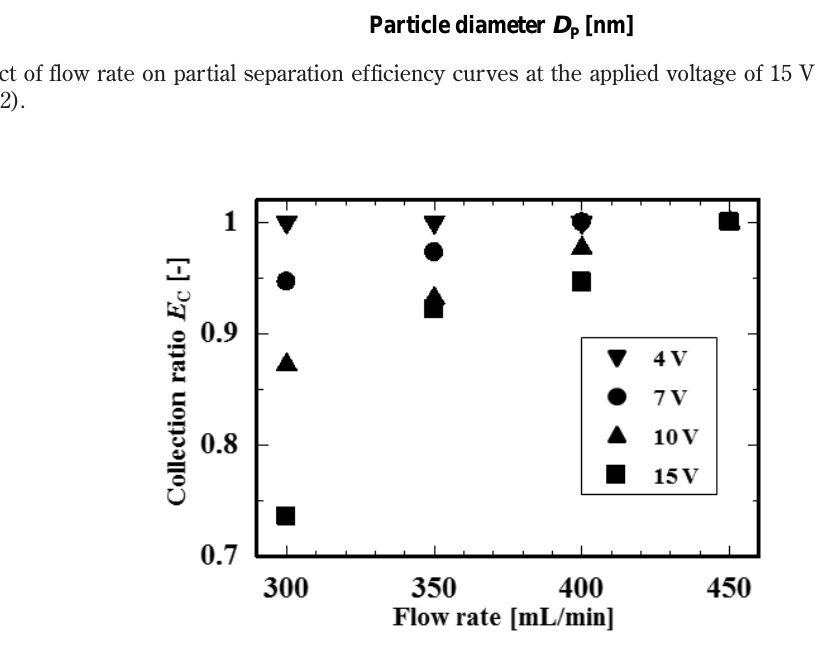
Fig. 10 Relationship between collection ratio and applied